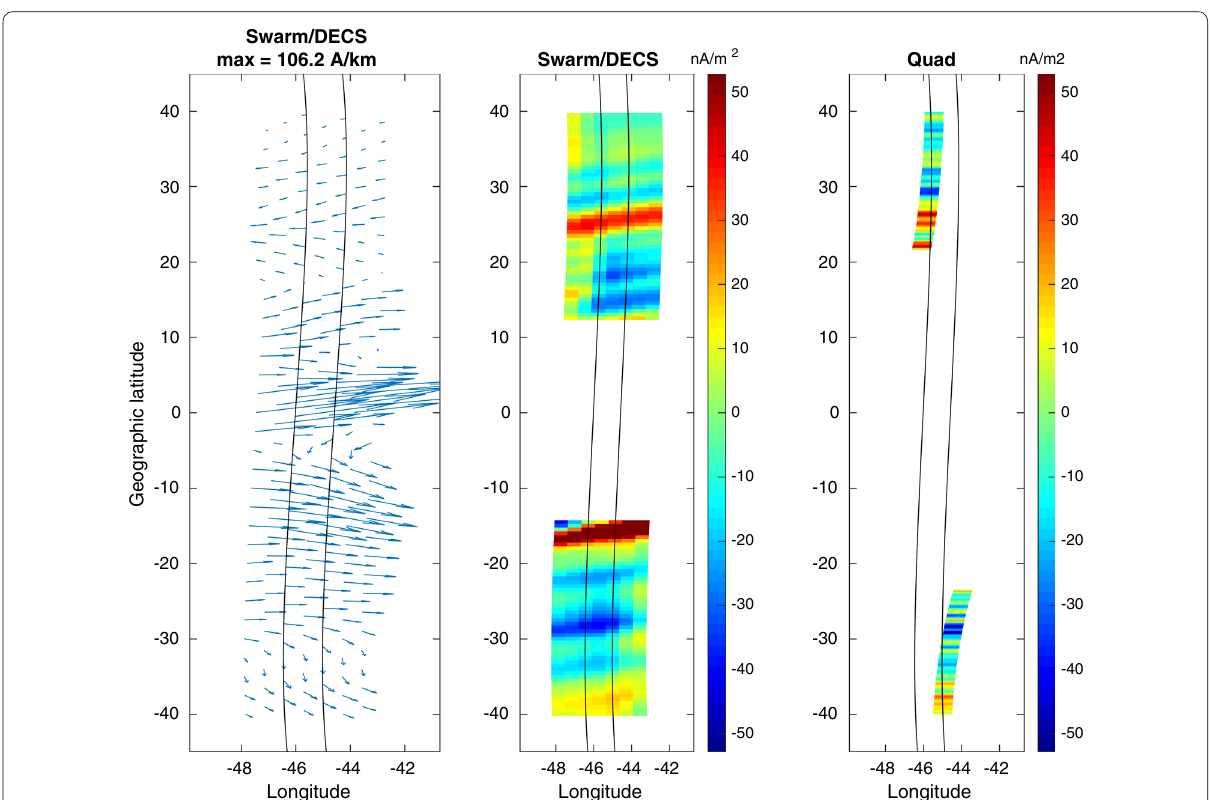
Fig. 8 Event E2. Maps of the E-region horizontal and radial currents. From left to right: the horizontal current from Swarm/DECS analysis the radial current from the Swarm/DECS analysis and the radial current from the quad method (Ritter et al. 2013). Swarm-A/C orbits are shown as black lines. Compare with the latitude profiles shown in Fig.